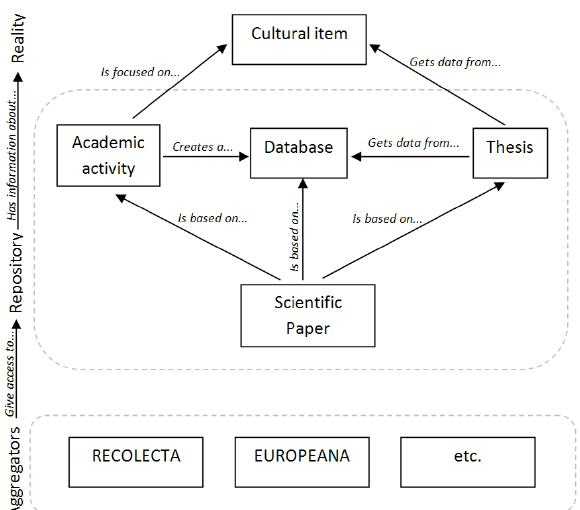
Figure 5. Structure of the information stored inside the repository